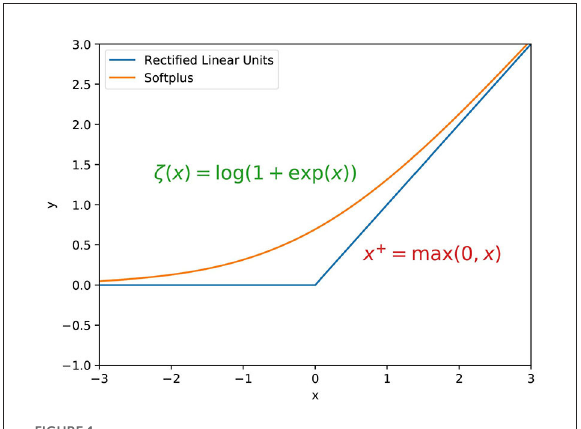
FIGURE1 Rectified Linear Unit and softplus activation